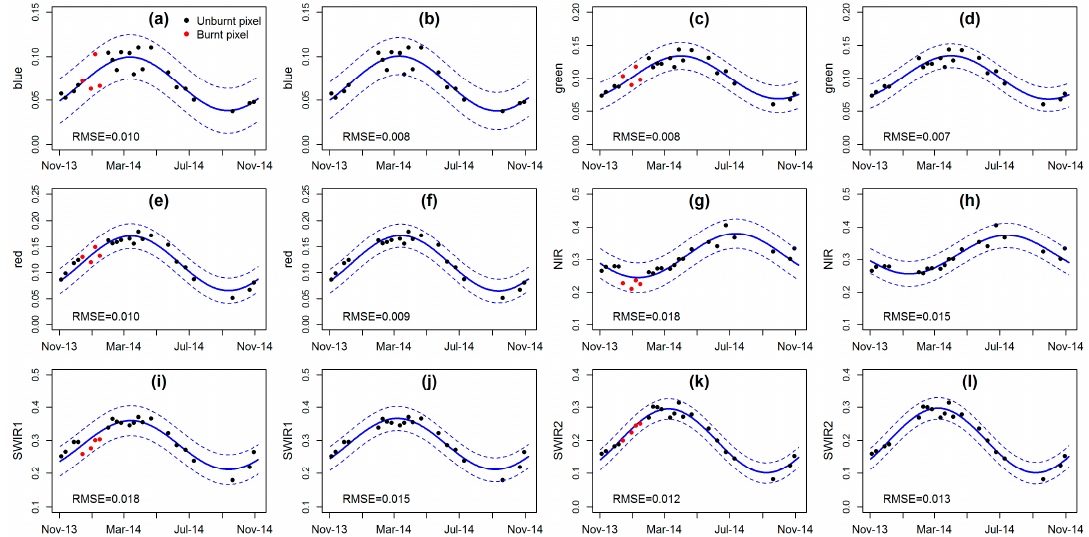
Figure 3. Time series model fit for a grassland savanna field plot without burnt pixel removal and with burnt pixel removal in blue ( a , b ); green ( c , d ); red ( e , f ); NIR ( g , h ); SWIR1 ( i , j ); and SWIR2 ( k , l ) spectral bands. Time series model fits without burnt pixel removal are shown in ( a,c,e,g,i,k ), and with burnt pixel removal in ( b,d,f,h,j,l ). The dashed line corresponds to 2.5 × RMSE.